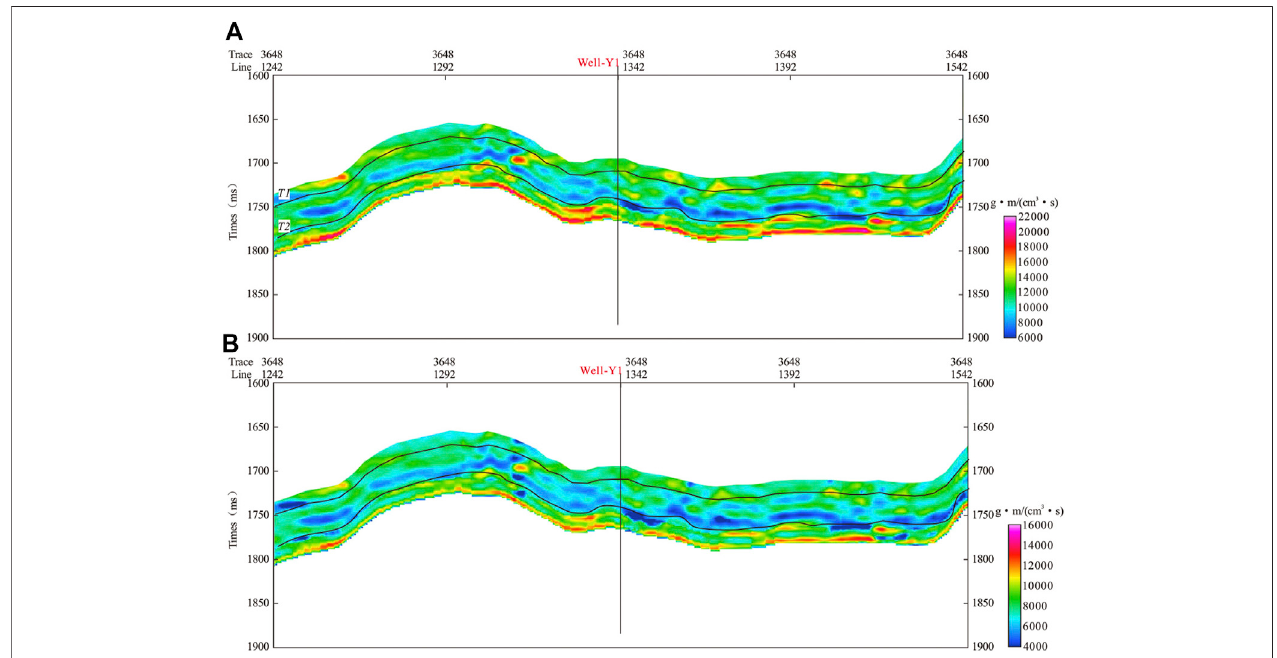
FIGURE9| Seismic inversion resultsoftheshale gas fi eld: (A) acoustic impedance and (B) shearimpedance. ThelocationofWell-Y1isindicatedbytheblack line.